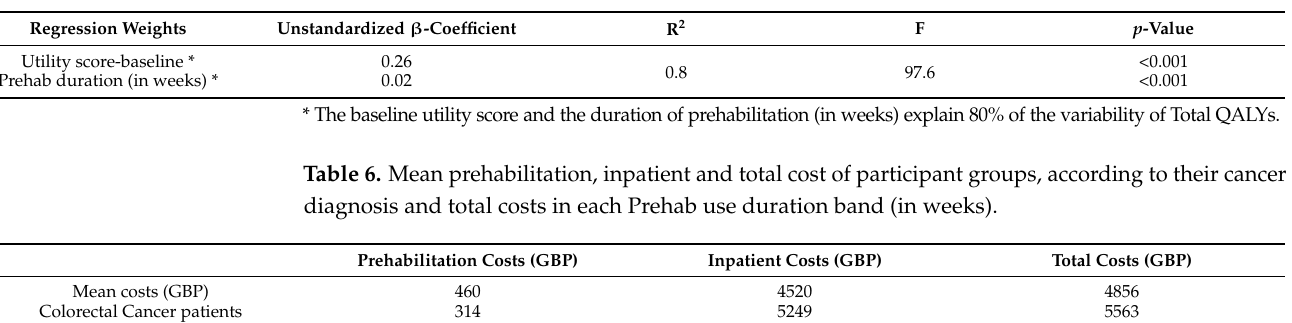
Table 5. Multivariate regression analysis with the dependent variable to be total QALYs.